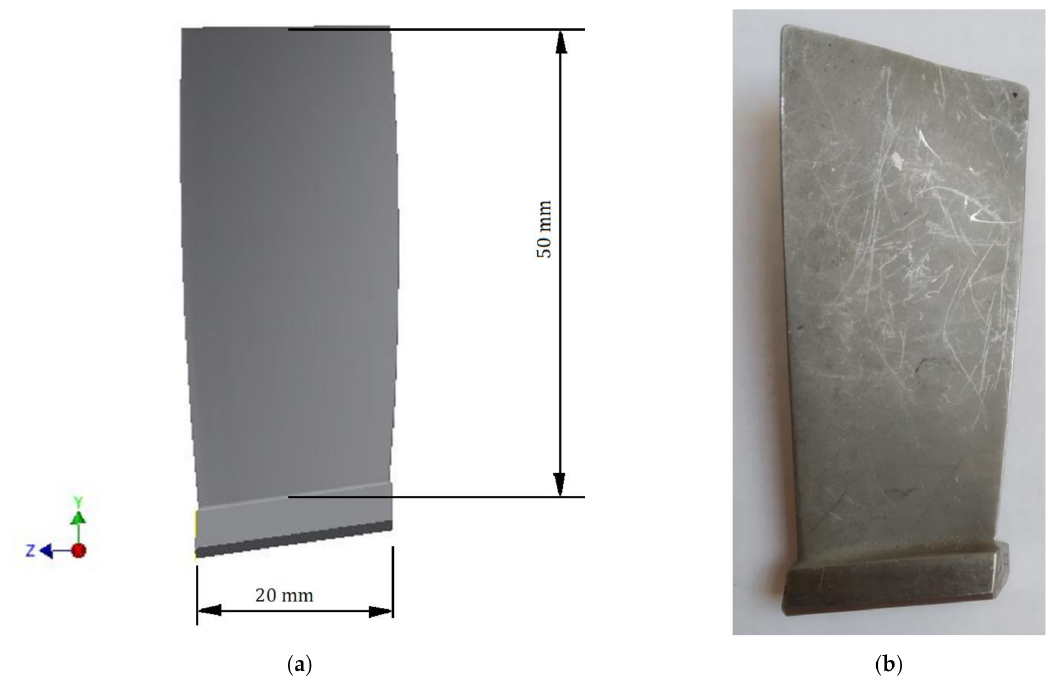
Figure 2. The geometrical model ( a ) of the examined blade ( b